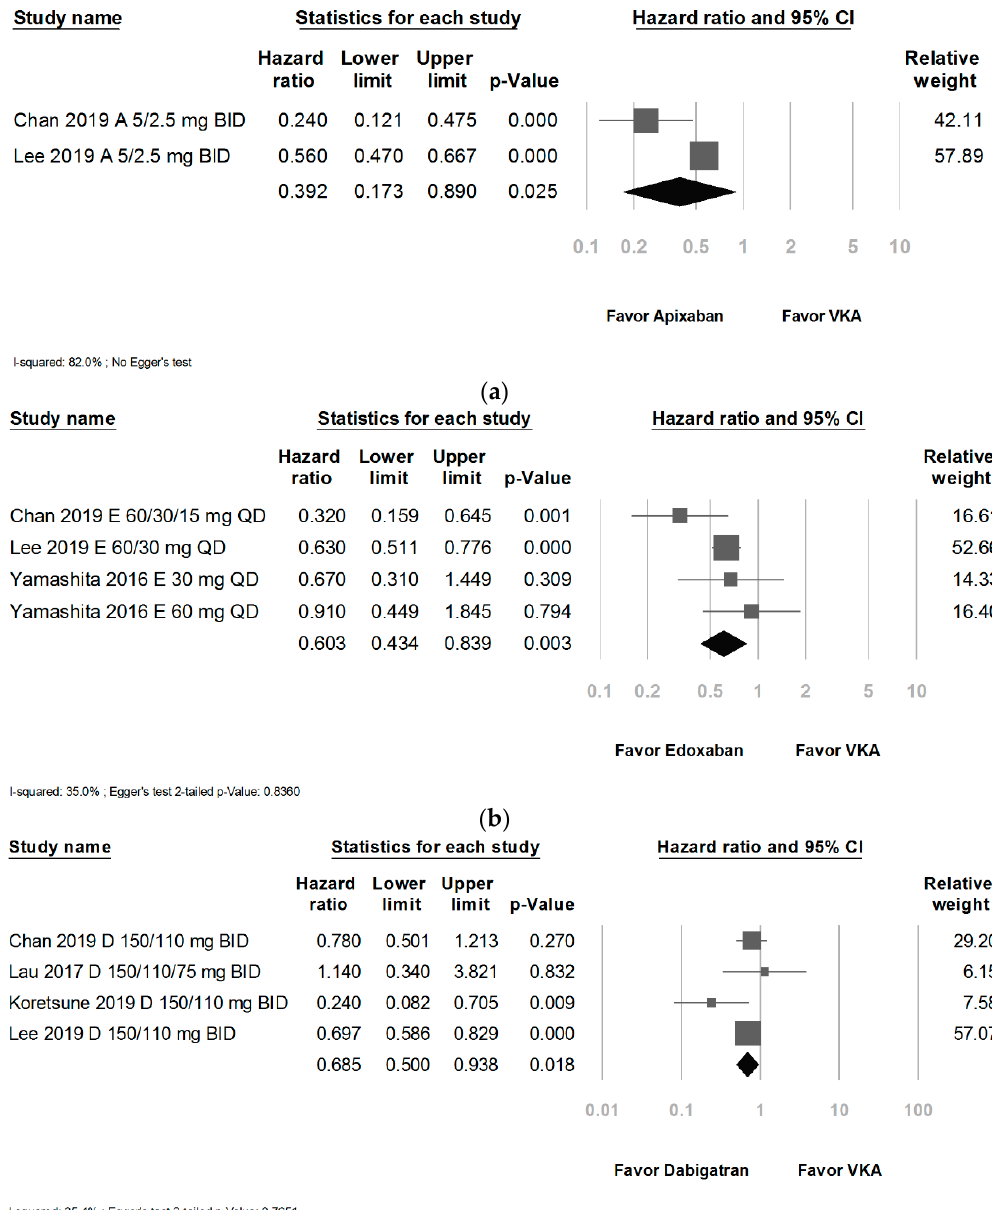
Figure 3. ( a ) Forrest plot of comparison: all novel oral anticoagulants versus vitamin K antagonists. ( b ) Forrest plot of comparison: the retrospective studies subgroup and the RCTs subgroup.